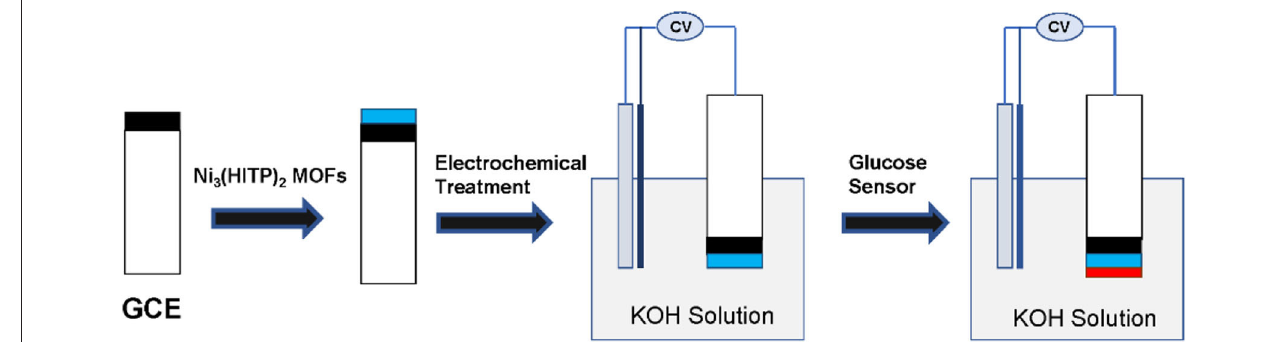
FIGURE 1 | Schematic image of electrochemical activated Ni-MOFs electrode for glucose sensor.